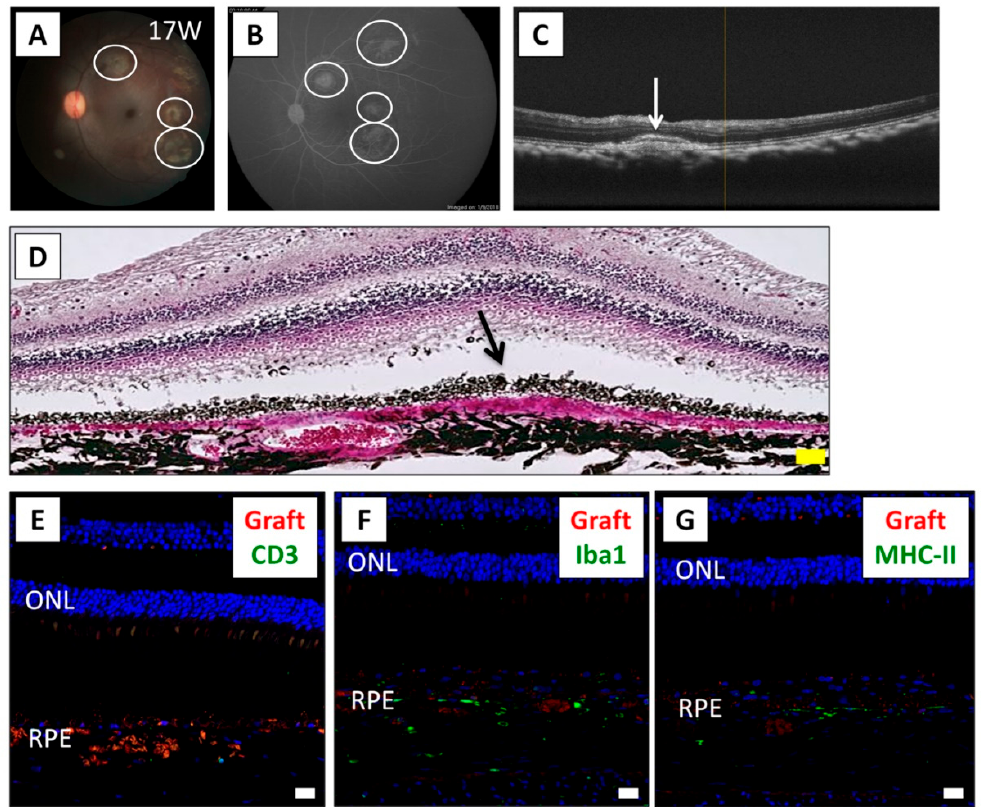
Figure 5. Results of iPSC-RPE transplantation while using local steroid therapy. ( A ) The fundus photograph of monkey HM-6 at 17 weeks after surgery, who was subjected to human iPSC-RPE transplantation with IVTA injection on day 0 and STTA injections at 4 and 12 weeks after transplantation. White circles show the transplanted sites. ( B ) Fluorescein angiography (FA) at late phase showed no hyperfluorescence around the grafts. No FA leakage was observed during the evaluation period. ( C ) Optical coherence tomography (OCT) revealed the presence of the cell aggregates of graft cells (arrow) in the subretinal space. ( D ) In H&E staining at 17 weeks after surgery, the graft cells (arrow) were observed in the subretinal space. Inflammatory cells were not obviously recognized. The overlying neurosensory retina was well preserved. Scale bar: 50 µ m. ( E – G ) IHC evaluation at 17 weeks after surgery. T cells were not observed in the retina ( E ). Although Iba1 + ( F ) and MHC class II + cells ( G ) were observed around the grafts, little invasion of these antigen-presenting cells was observed throughout the retinal sections. PKH + RPE cells (red), indicating live grafts, were detected in the subretinal space. Nuclei were stained by DAPI (blue). Scale bars: 20 µ m. ONL: outer nuclear layer.